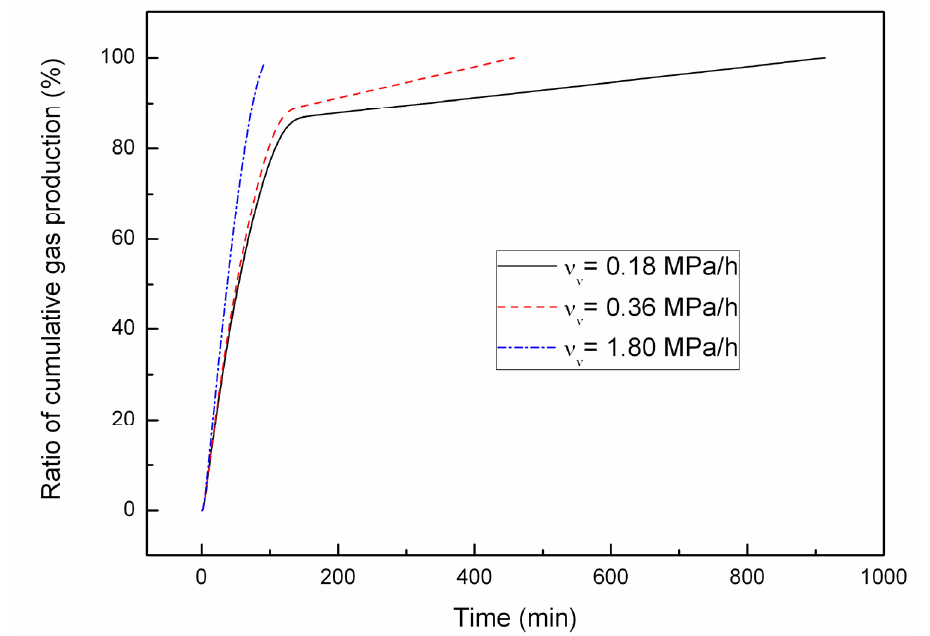
Figure 7. The percentage of cumulative gas production time evolution for different depressurizing